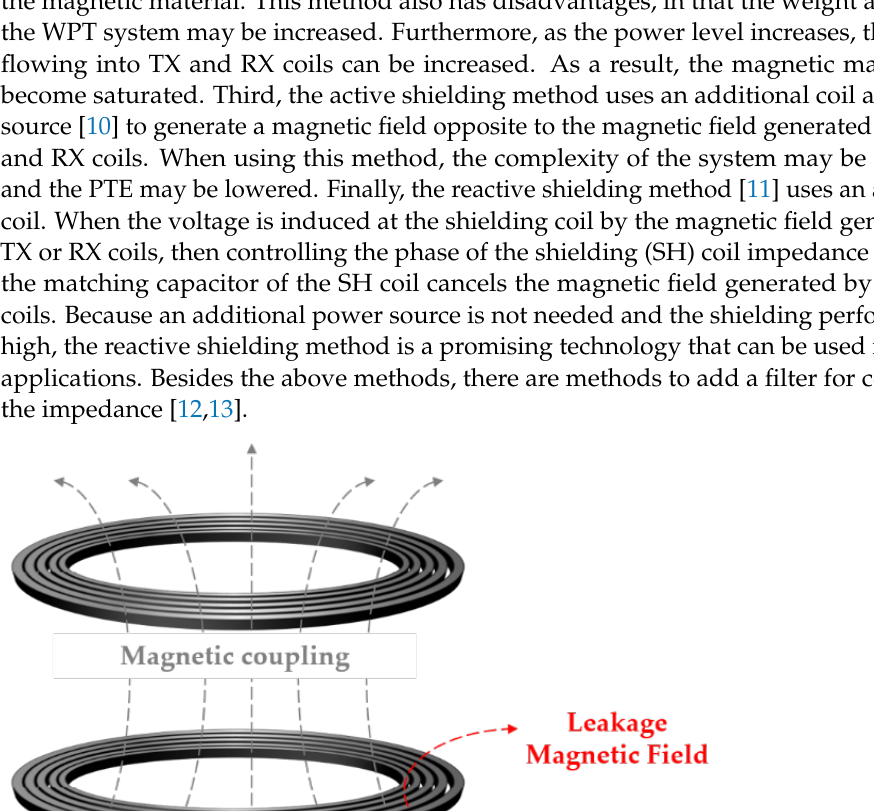
Figure 1. Coupled and leakage magnetic field in the process of transferring power wirelessly.